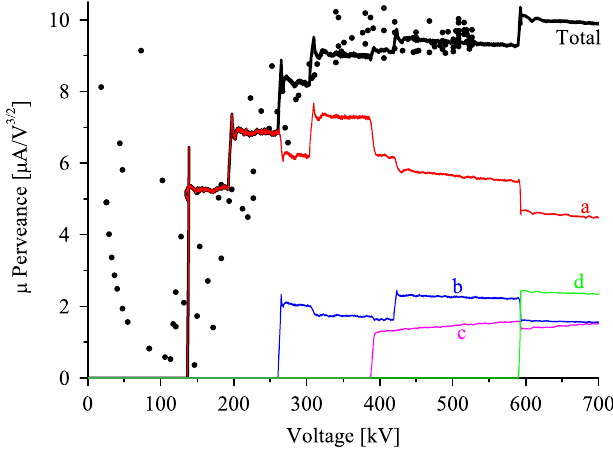
FIG. 7. (Color) Perveance with respect to voltage. The partial perveance and the total perveance compared to the experimental result. Dots represent the experimental perveance and the thick solid line is the perveance of total current. Other lines show the partial perveances of separated areas: (a) outer edge, (b) inner edge, (c) outside, and (d)